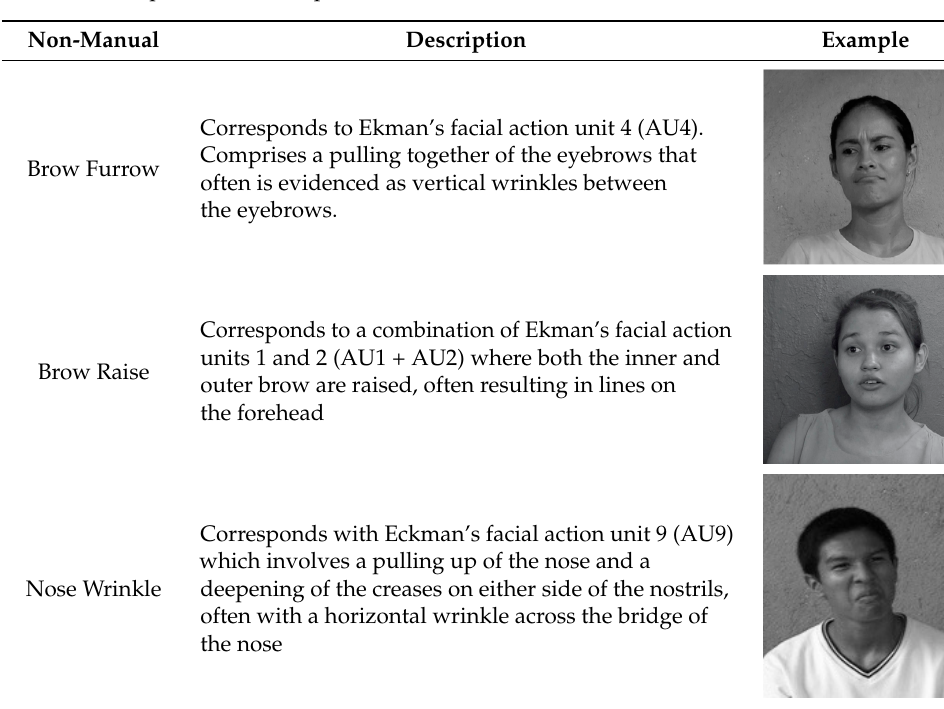
Figure 1. Examples of the LSN wh-question words that were elicited. Table 2. Descriptions and examples of the six non-manuals coded.